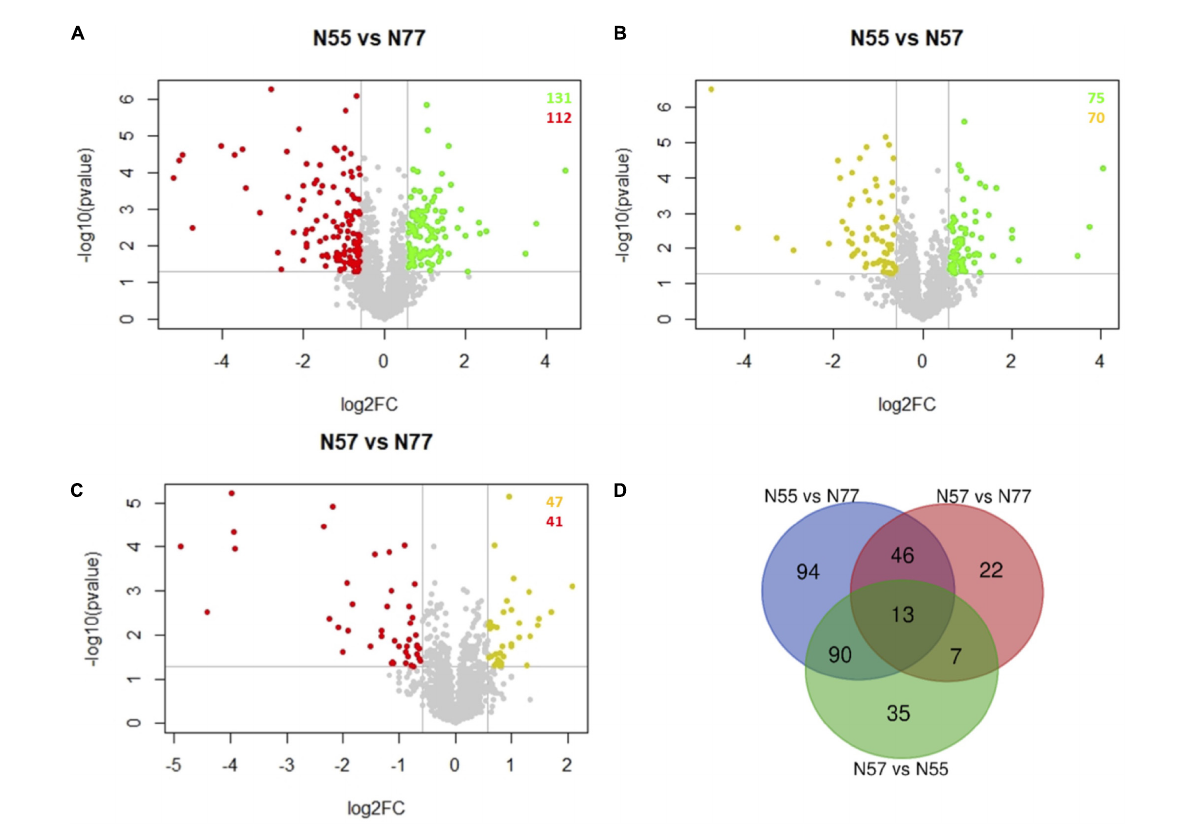
FIGURE2 Volcano plots and Venn diagram of protein abundance differences between conditions. (A–C) Volcano plots of the proteins differentially abundant between each pair of experimental conditions (FC > 1.5, p -value < 0.05). Spots representing proteins with increased abundances in N55, N57 and N77 are coloured in red, yellow and green, respectively. (A) N55 vs N77; (B) N55 vs N57; and (C) N57 vs N77. (D) Venn diagram showing the number of proteins that are differentially abundant in the several comparisons of experimental conditions (N55 vs N77, N55 vs N57 and N57 vs